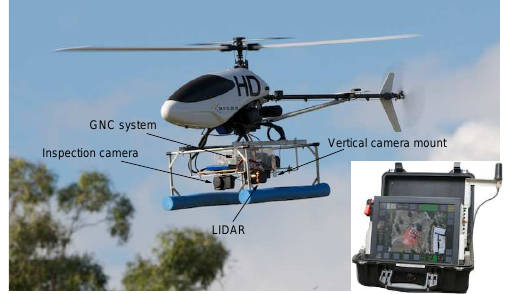
Figure 1: The CSIRO autonomous helicopter